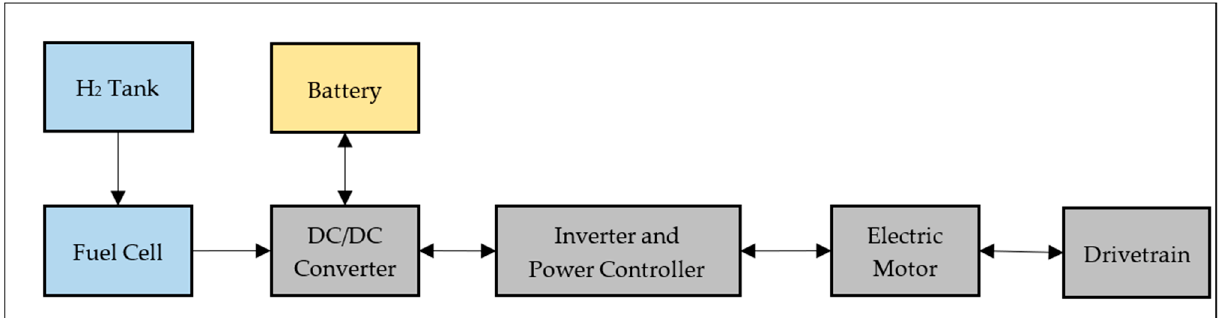
Figure 1. A configuration scheme of the main FCEV powertrain components.